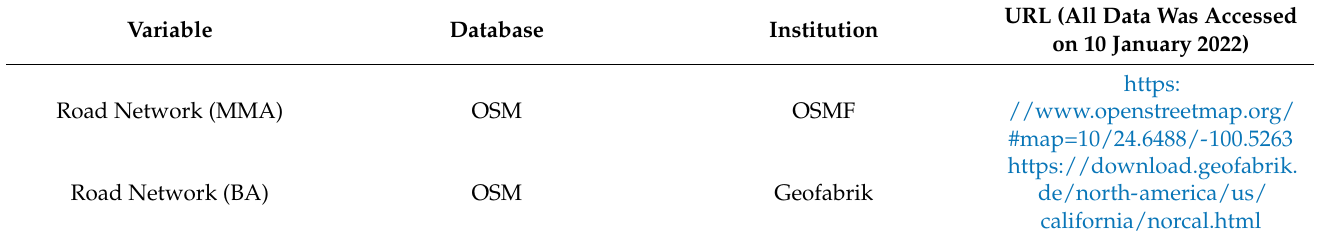
Table 5. Road Network Datasets.